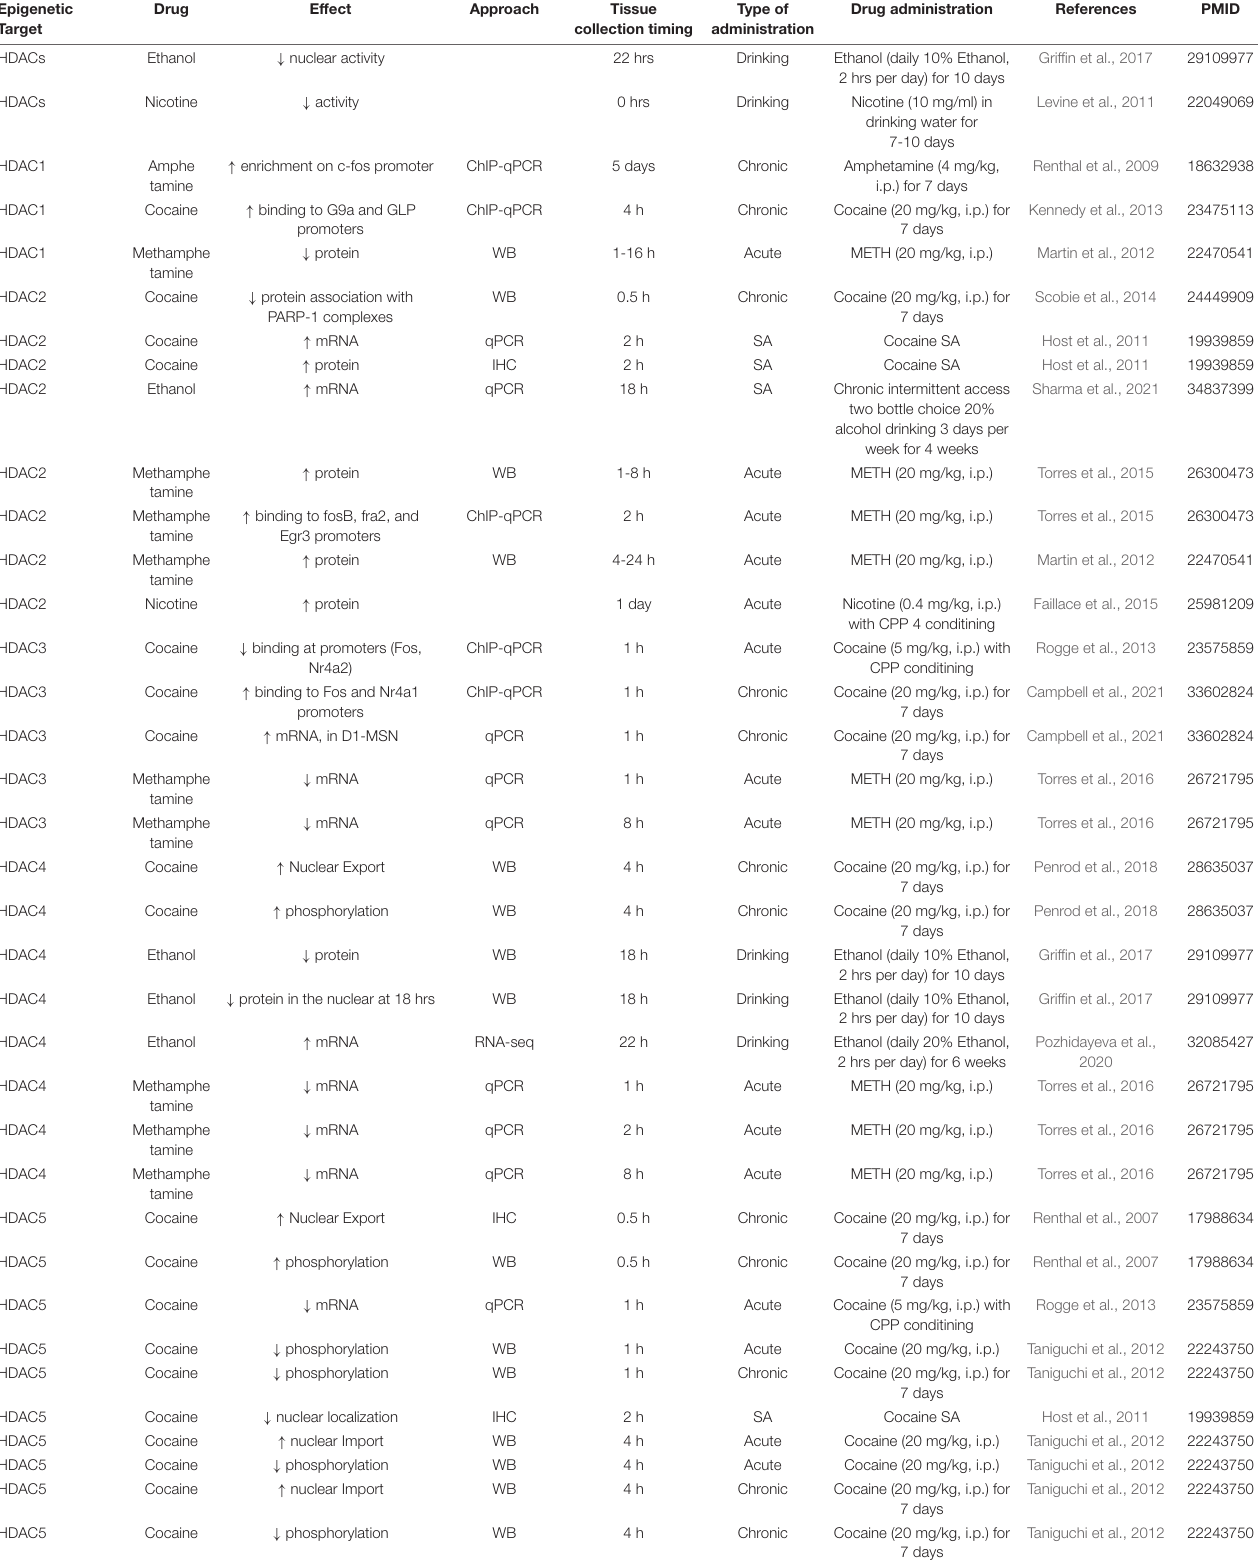
TABLE 3 | Effects of drug exposure on epigenetic regulators in the NAc. Epigenetic